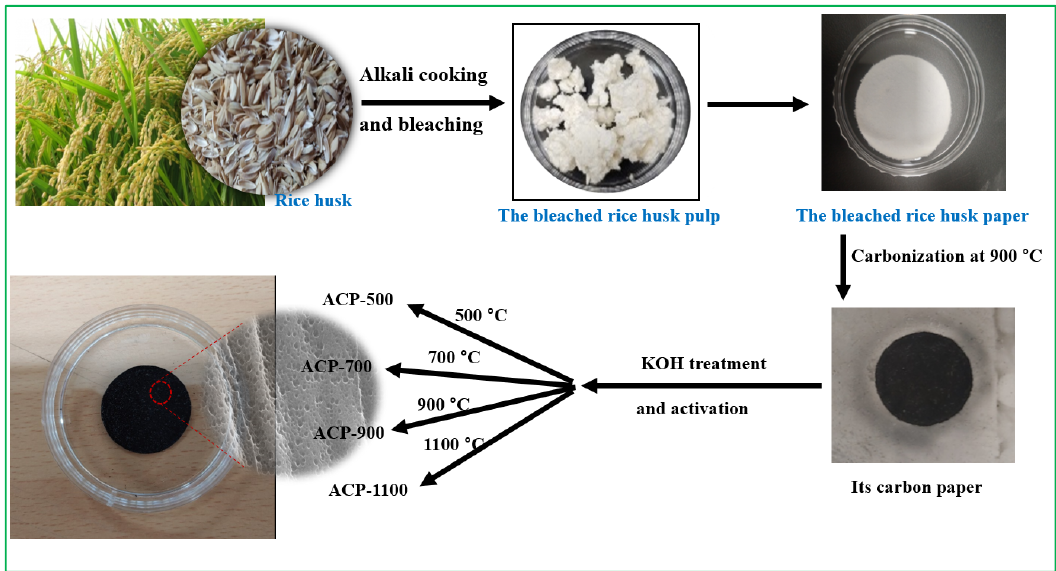
Figure 9. ACP preparation method: schematic diagram showing preparation of ACP-500, ACP-700, ACP-900, and ACP-1100 with photographs of the samples acquired during processing.